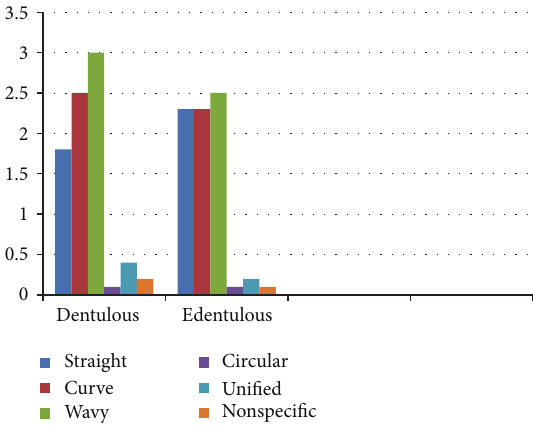
Figure 4: Comparison of rugae patterns among dentulous and edentulous subjects.